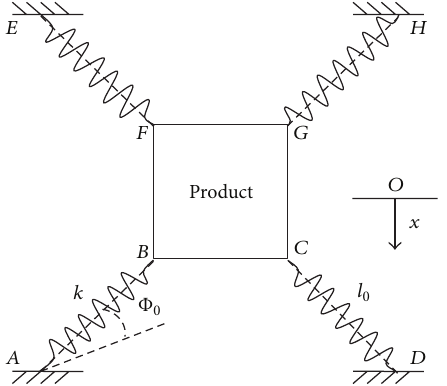
Figure 1: Dynamic model of the suspension spring system.